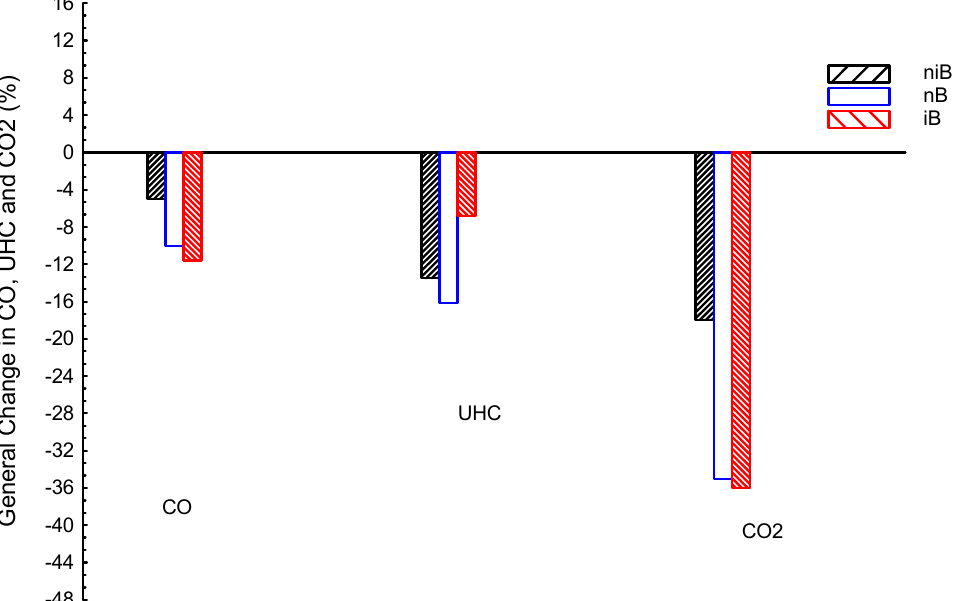
Figure 11. CO, CO 2 , and UHC emissions averages for blended fuels of n-butanol–iso-butanol–gasoline (niB), n-butanol–gasoline (nB), and iso-butanol–gasoline (iB); gasoline is the reference line.